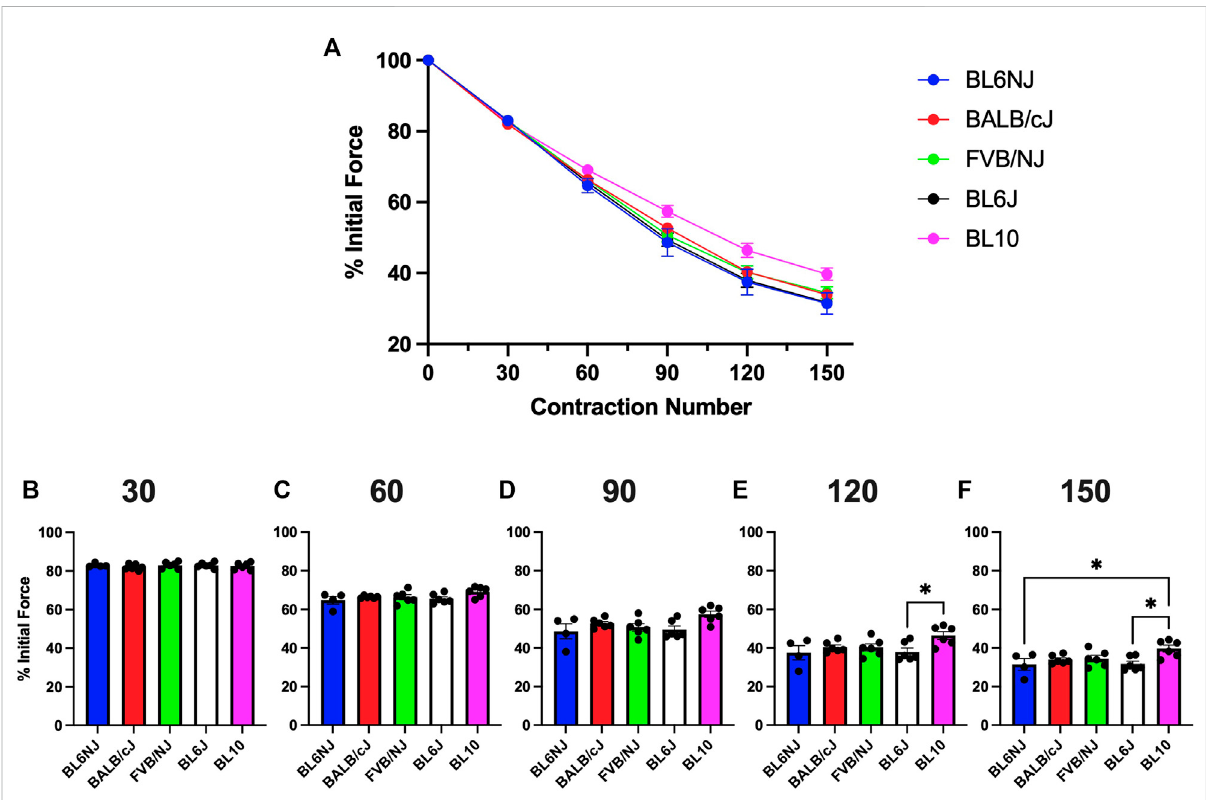
FIGURE 5 (A – F) . Isometric fatigue of the EDL muscle from various strains of mice. (A) Fatigue curve (Blue = BL6NJ, Red = BALB/cJ, Green = FVB/NJ, Black = BL6J, Pink = BL10), (B) percent initial force produced after 30 contractions, (C) percent initial force produced after 60 contractions,